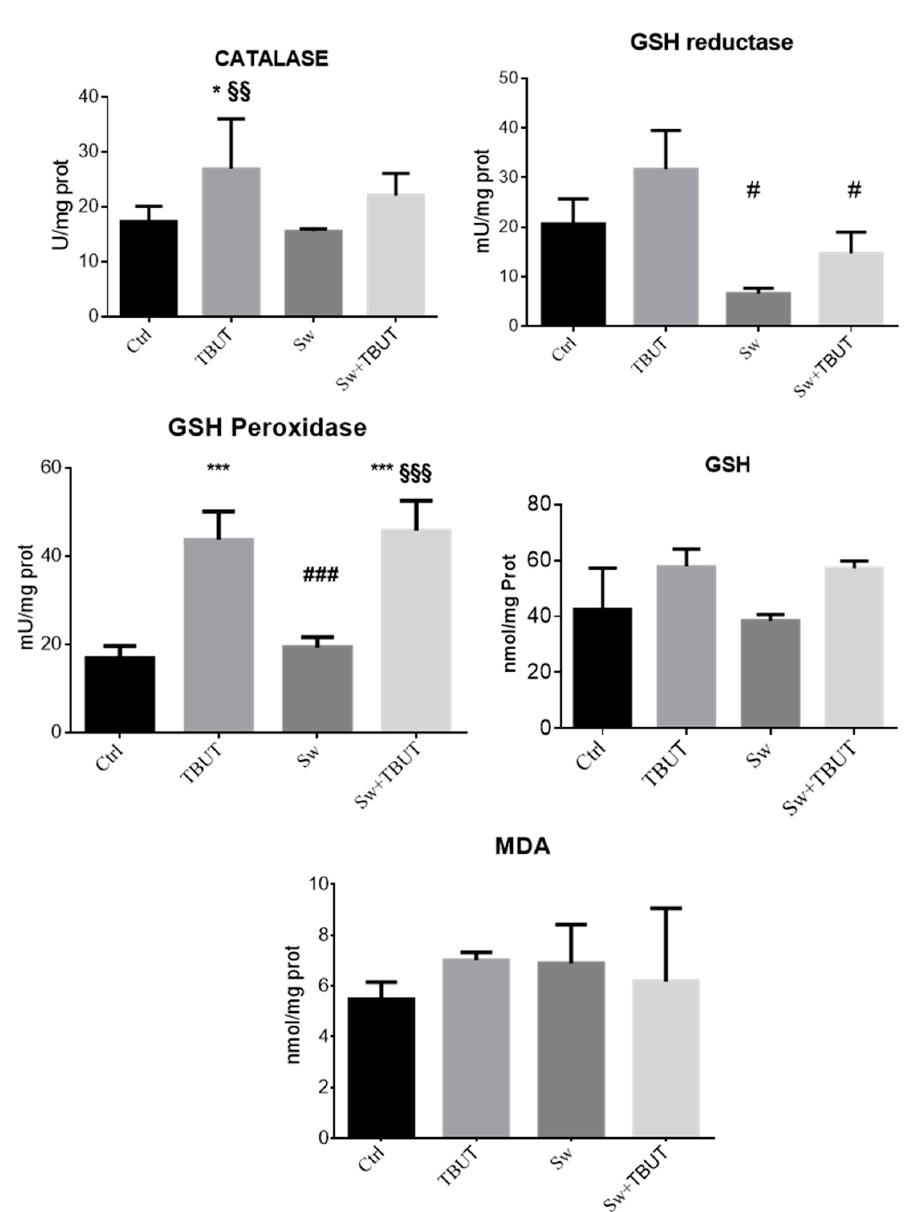
Figure 2. Protective effects of seaweed extract assessed in HepG2 cells exposed to oxidative stress (TBUT) with or without 62.5 μ g/mL seaweed extract (Sw). The main antioxidant enzymes are represented together with glutathione (GSH) and malonyldialdehyde (MDA) cell content. Values are expressed as mean ± SD of three independent experiments. * vs. Ctrl (* p < 0.05, *** p < 0.001); § vs. Sw (§§: p < 0.01, §§§: p < 0.001) and # vs. TBUT (#: p < 0.05, ###: p < 0.001).